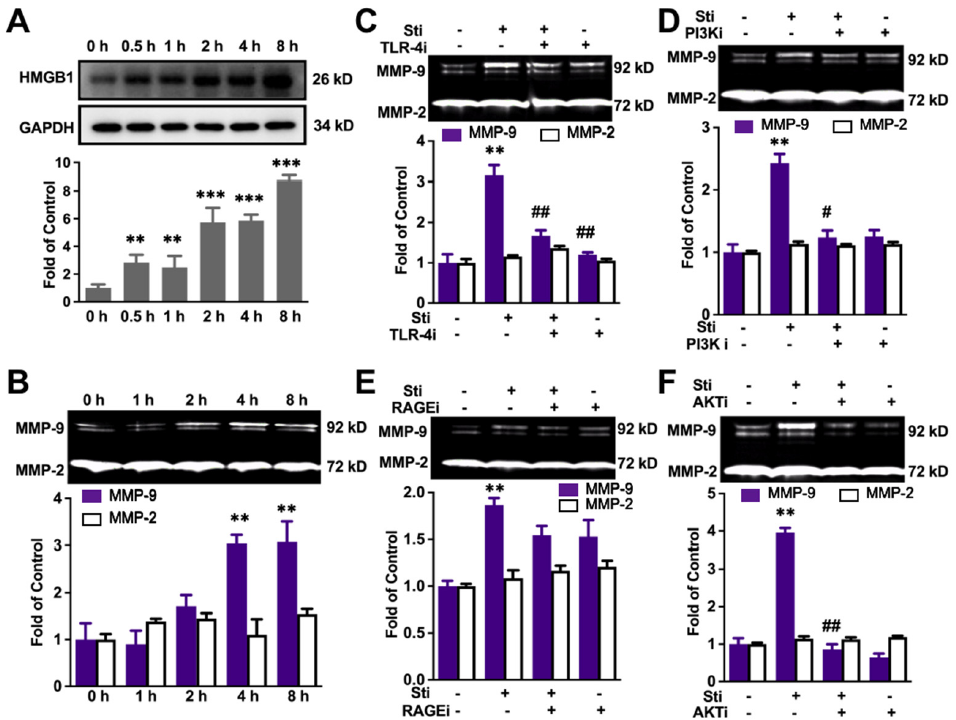
Figure 4. The increase of MMP-9 in cultured macrophages depends on the HMGB-1/TLR- 4/PI3K/Akt pathway. ( A ) Cisplatin-induced increase of HMGB-1 in a time-dependent manner in cultured SH-SY5Y cells. ( B ) Stimulated supernatant induced an increase of MMP-9, but not MMP2, in a time-dependent manner in cultured Raw 264.7 cells. ( C ) TLR-4 inhibitor suppressed MMP-9 increase in Raw 264.7 cells. ( D ) The role of RAGE inhibitor in MMP-9 in Raw 264.7 cells. ( E ) IP3K inhibitor suppressed MMP-9 increase in Raw 264.7 cells. ( F ) Akt inhibitor suppressed MMP-9 increase in Raw 264.7 cells. The significant difference was revealed following one-way or two-way ANOVA ( p ** < 0.05, p *** < 0.001 vs. control or 0 h. p # < 0.05, p ## < 0.01 vs. stimuli group. Tukey post